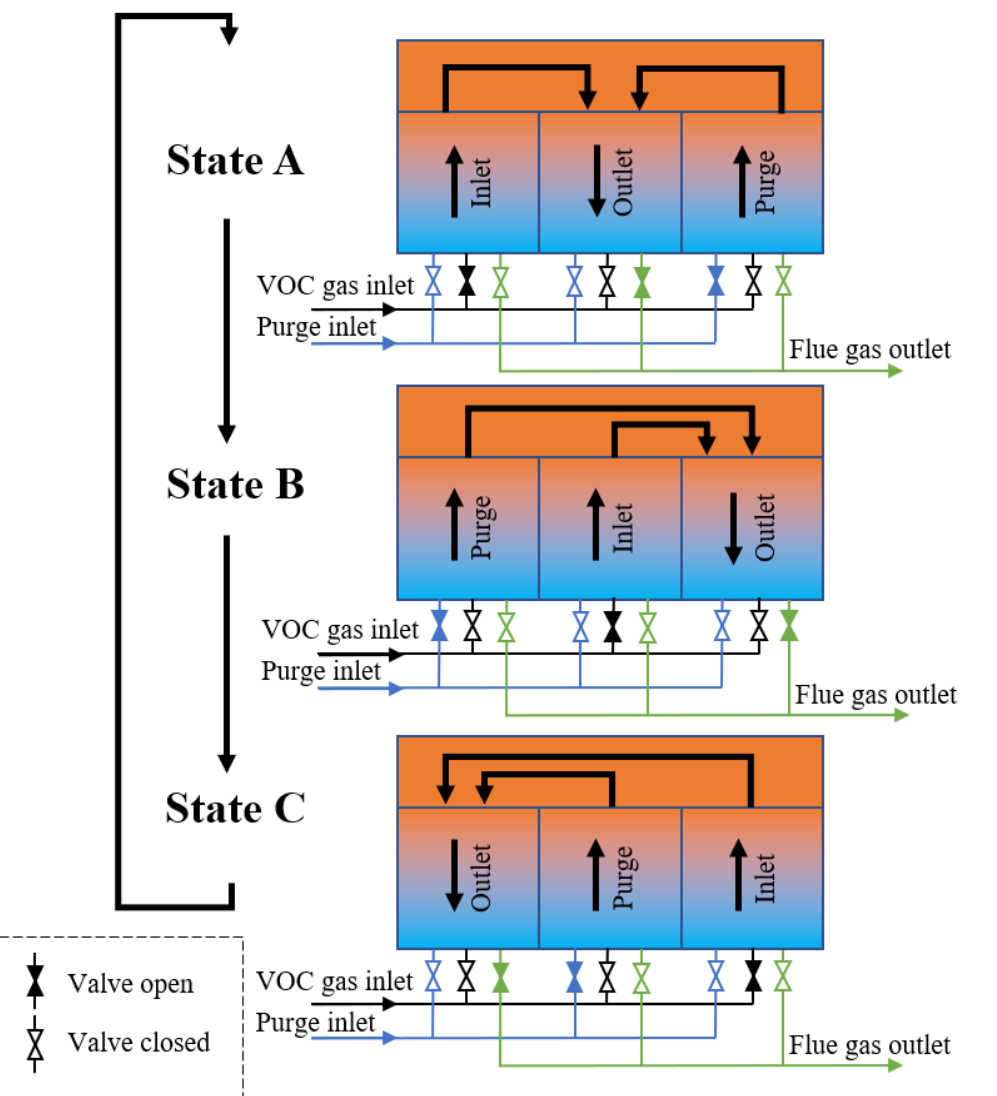
Figure 2. Working circulations of the regenerator with three states (VOC refers to volatile organic compounds).